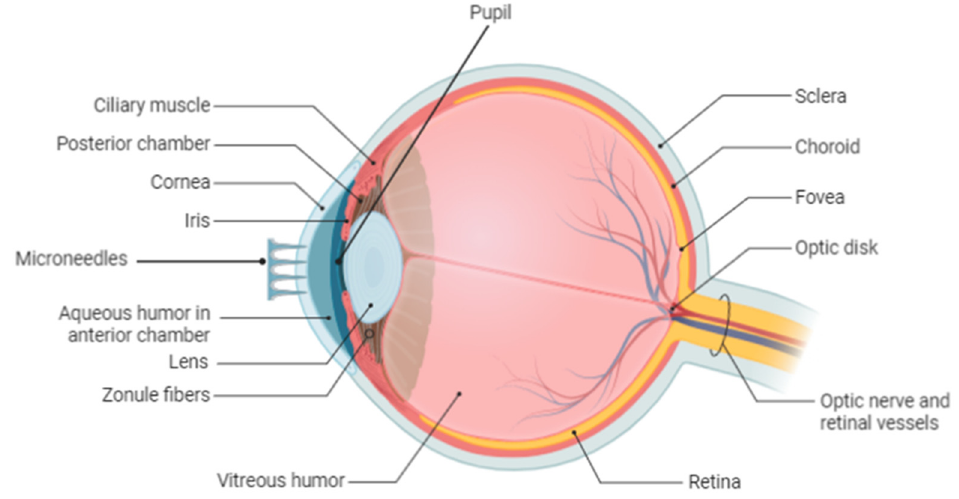
Figure 7. Human eye: anatomical features with the microneedles array